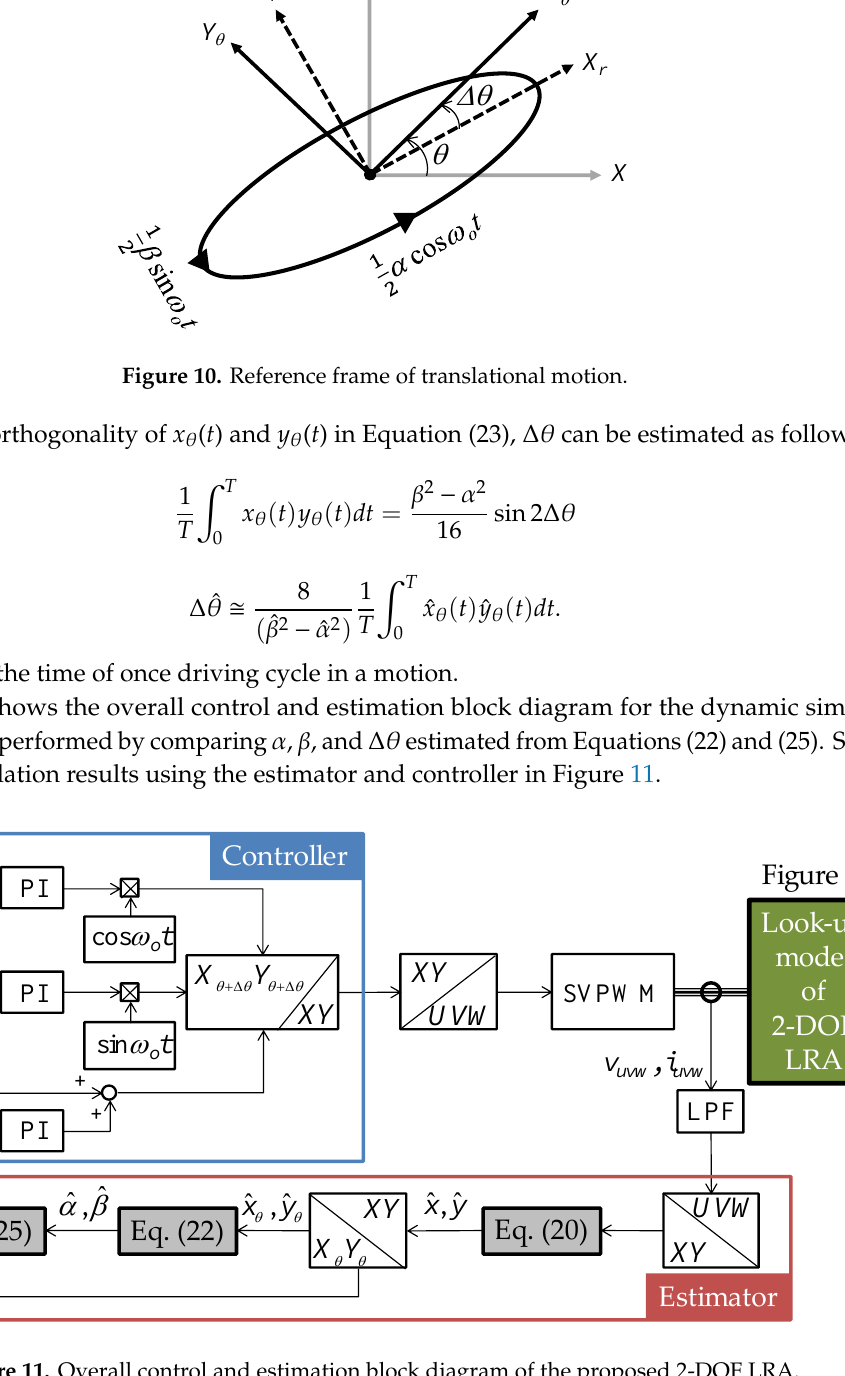
Figure 11. Overall control and estimation block diagram of the proposed 2-DOF LRA